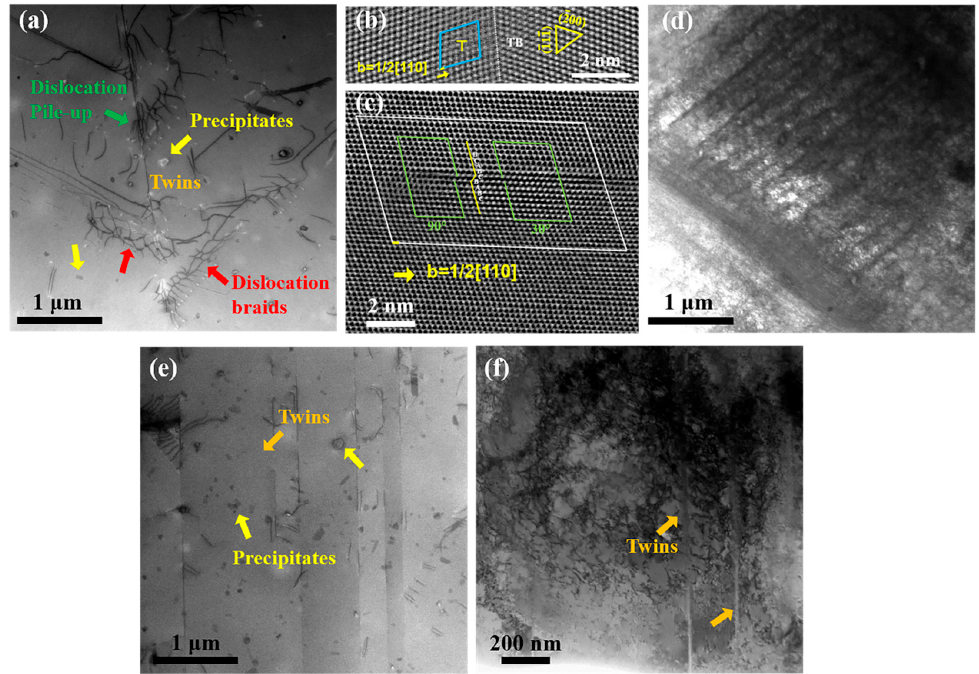
Figure 7. The STEM observation of the HTed samples. The 1177-AC before ( a – c ) and after ( d ) the tensile deformation. The 1177-WQ before ( e , f ) after the tensile deformation.